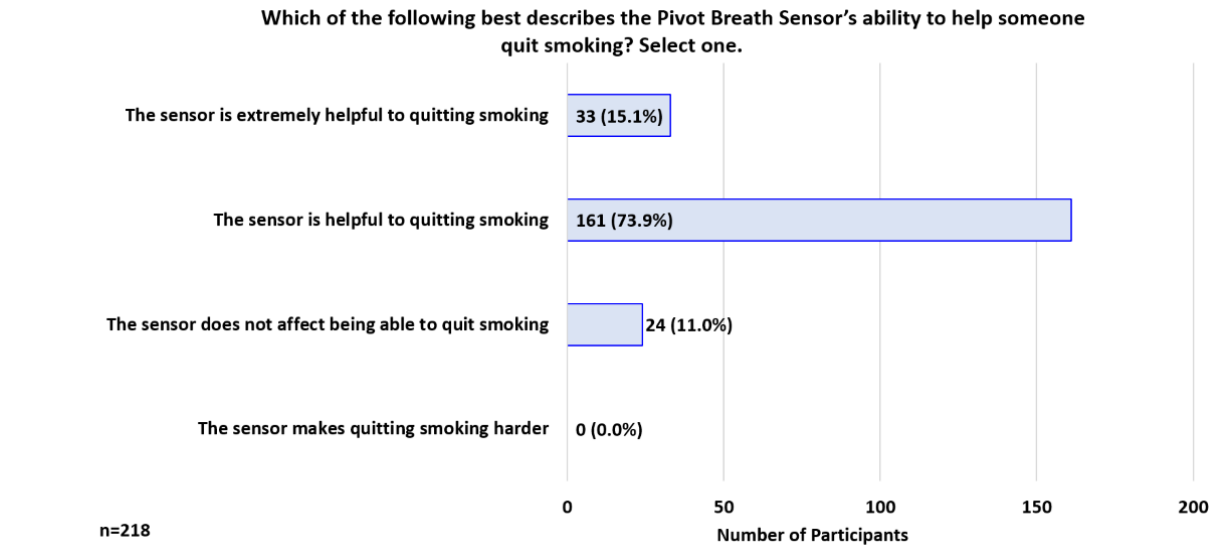
Figure 10. Participant Feedback: Pivot Breath Sensor’s ability to help someone quit smoking (week 2).